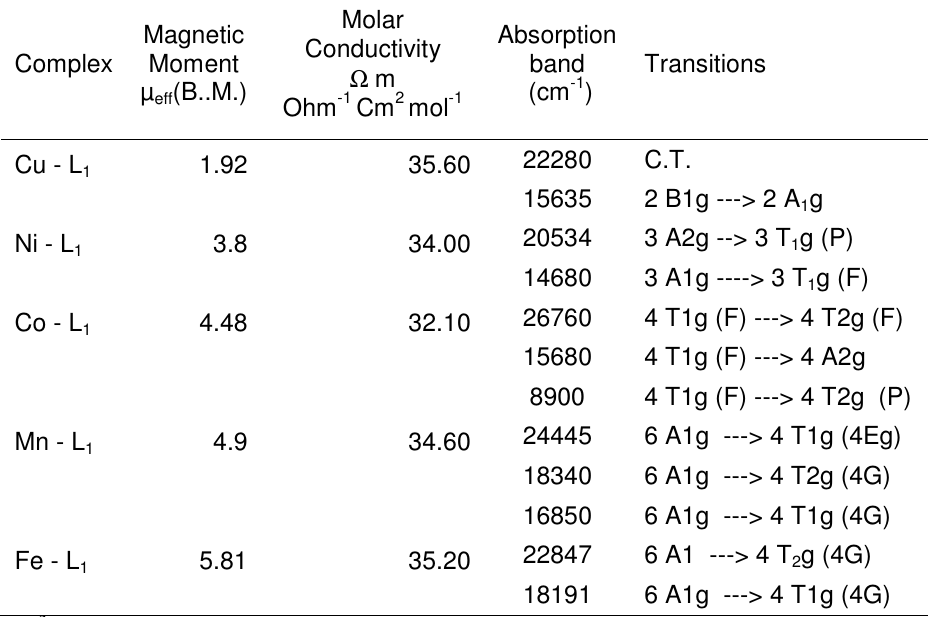
Table - 2 Magnetic Moment & Reflectance Spectral data of the Metal